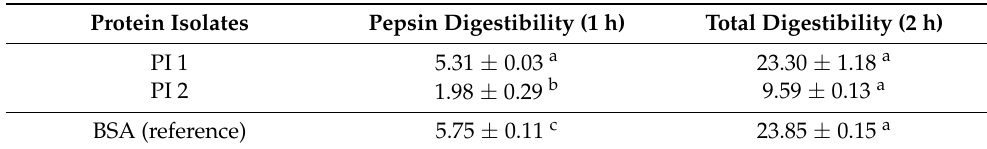
Table 3. In vitro protein digestibility (IVPD) (%) of protein isolates according to the stage of digestion over short-term digestion.